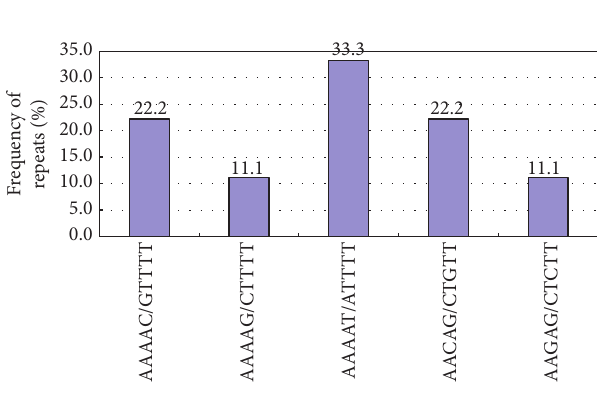
Table 5: Sequence length of